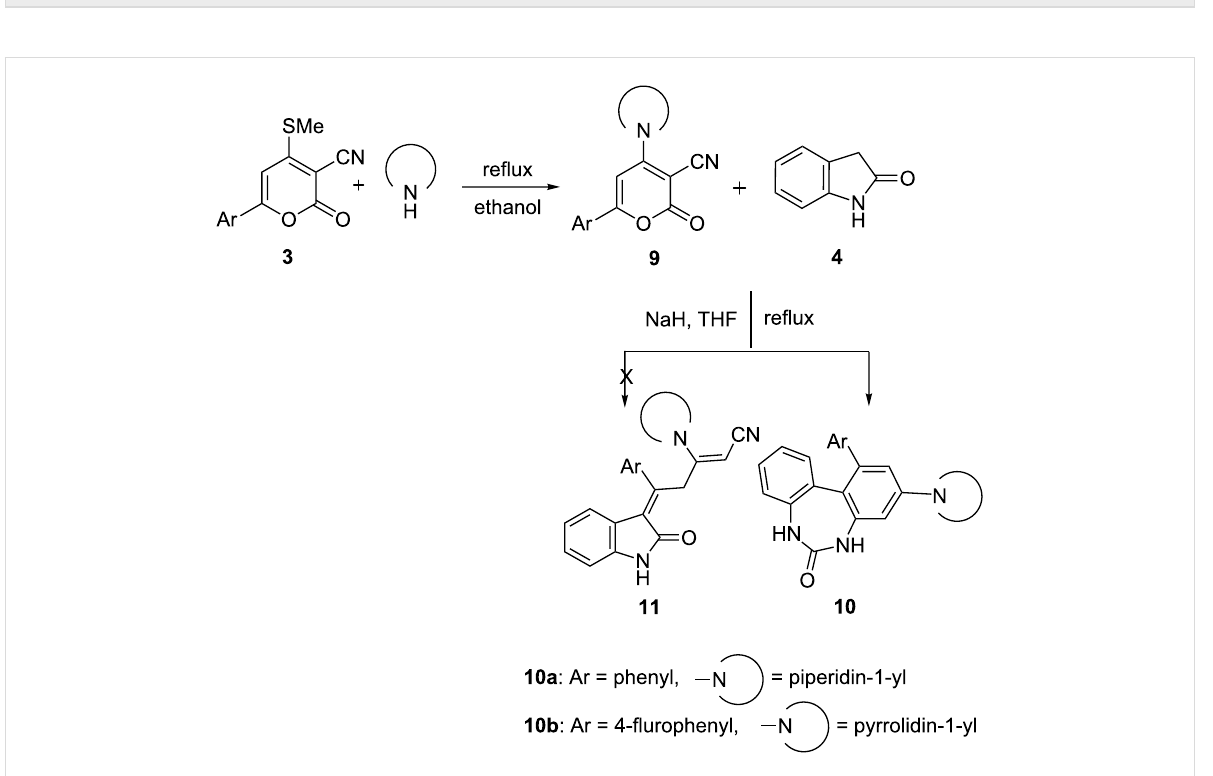
Scheme 3: Synthesis of